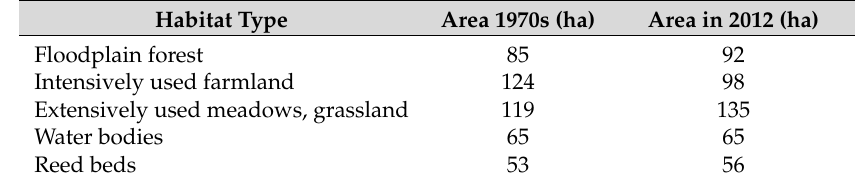
Table 5. Habitat composition at “Lampertheimer Altrhein” between the 1970s [14] and 2012